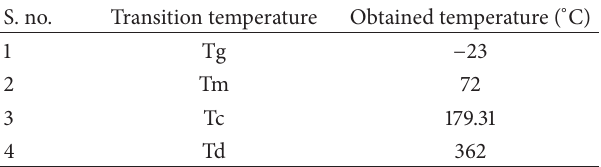
Figure 6: X-ray diffractogram of PIFB. Table 2: DSC data of copolyester